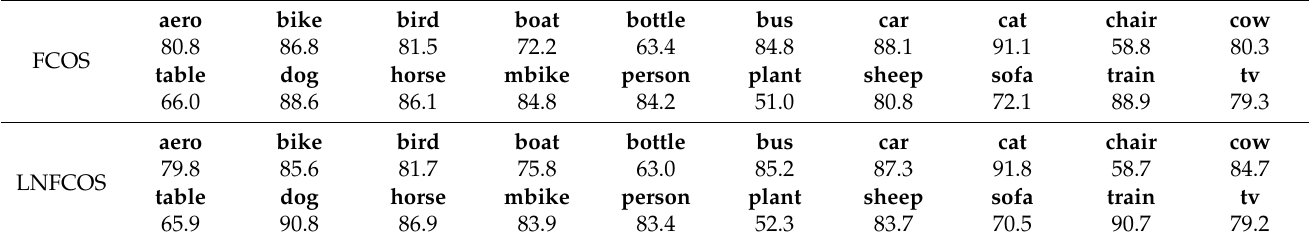
Table 4. The ablation study for LNFCOS analysis on the PASCAL VOC 2007 test